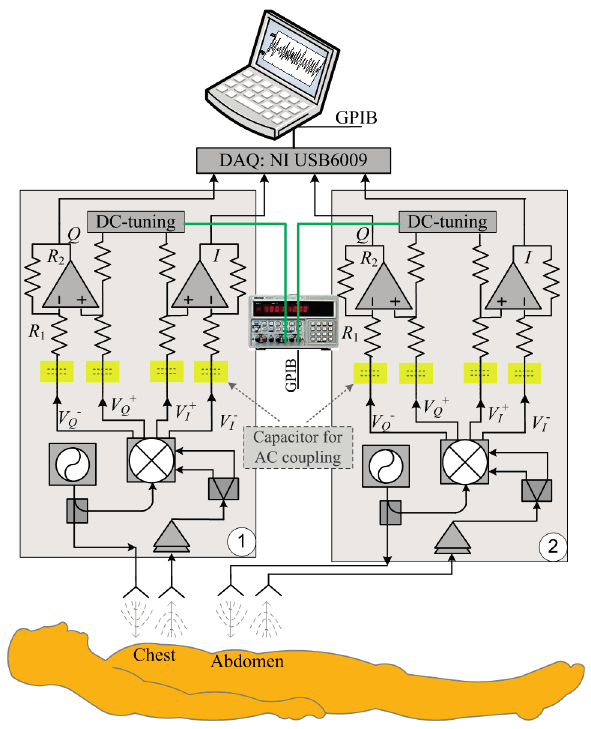
Figure 1. Block diagram of the DC coupled multi-radar system for respiration assessment at chest and